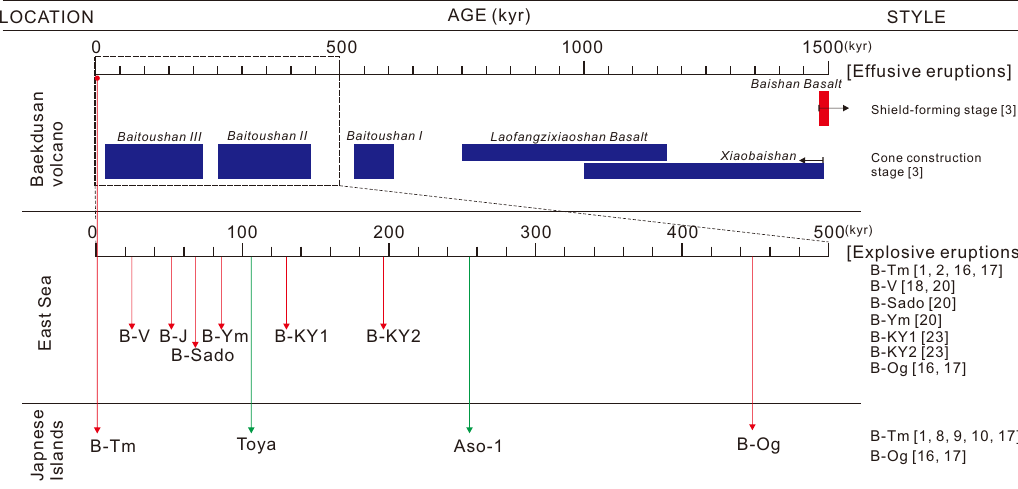
Figure 2. Volcanic history of Baekdusan. The shield-forming and cone construction stages originated from e ff usive eruptions of Baekdusan (Data from [3]). Eight tephra layers in East Sea marine sediments and two tephra layers in Japanese island sediments caused by Plinian eruptions of Baekdusan (Data from [1–3,8–10,16–18,20,22,23]). Toya and Aso-1 tephra layers (green arrows) in the ODP 794A core were transported by explosive volcanic eruptions of Japanese volcanoes (Data from